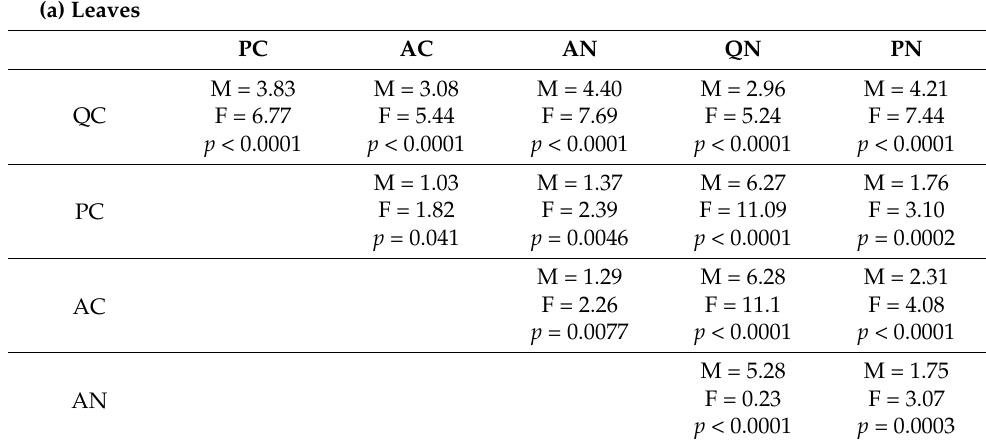
Table 2. ( a ) Squared Mahalanobis distances between species-treatment in leaves. ( b ) Squared Mahalanobis distances between species-treatment in litter. AC = A. unedo control plot. PC = P. latifolia control plot. QC = Q. ilex control plot. AN = A. unedo N-fertilized plot. PN = P. latifolia N-fertilized plot. QN = Q. ilex N-fertilized